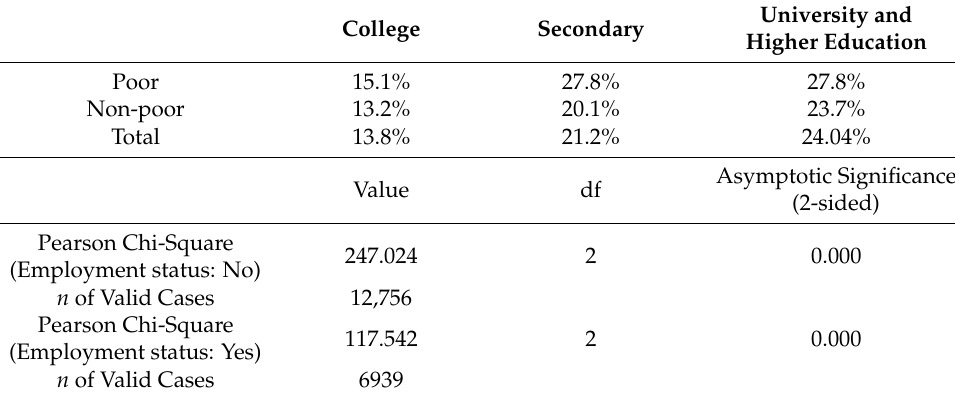
Table 4. Youth unemployment rate by education level and poverty status, 2013–14.